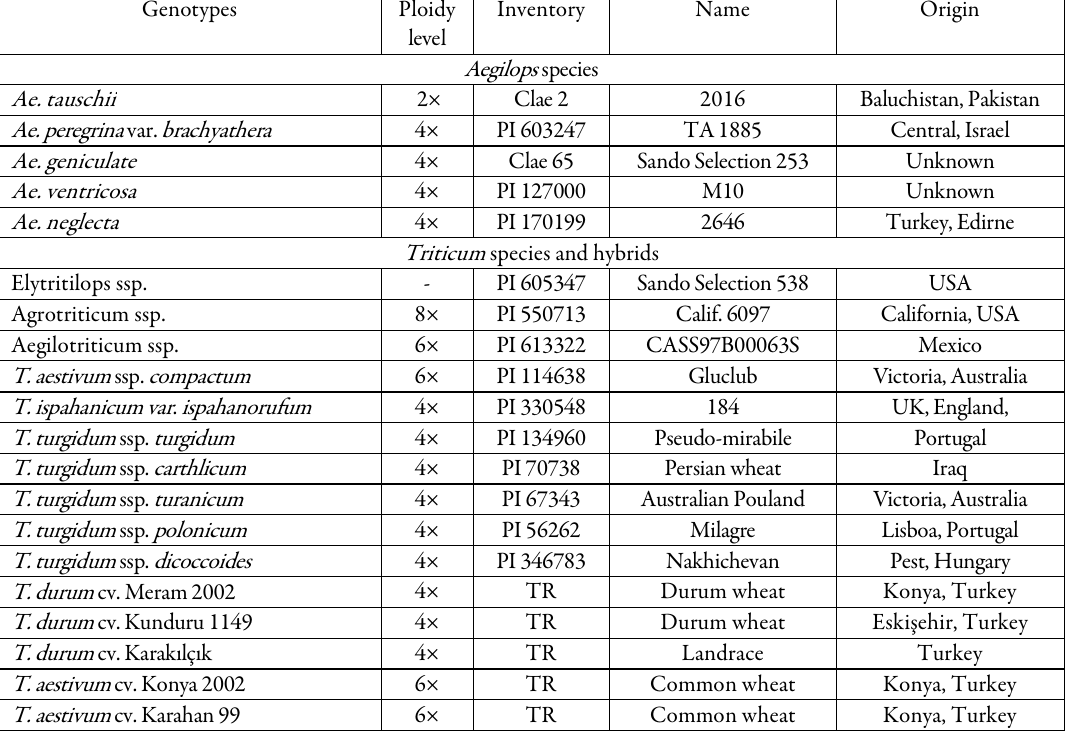
Table 1. Traits of genotypes involving Triticum species, Aegilops species, and wheat hybrids used in